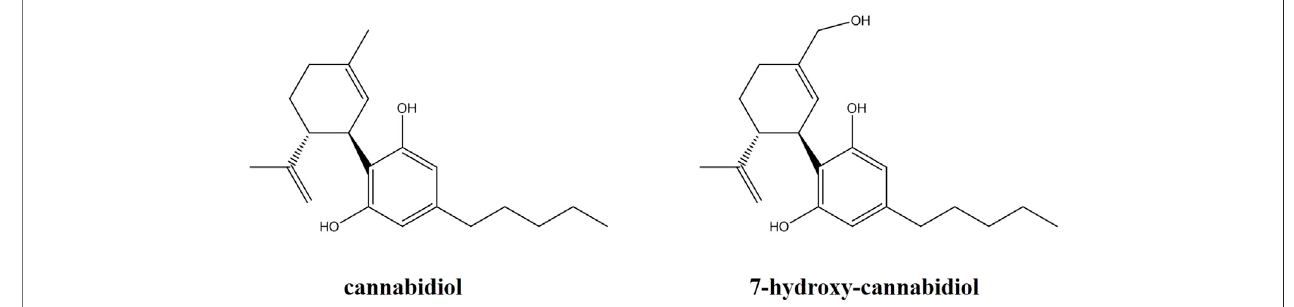
FIGURE 1 | Chemical structures of cannabidiol and its active metabolite 7-hydroxy-cannabidiol.